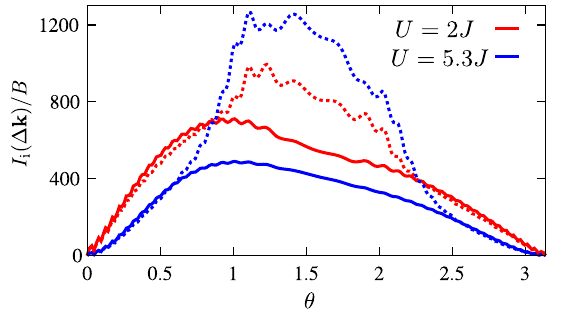
light.FIG. 12. Comparison of the angular distribution of the inelastic scattered light intensity based on MFT (solid lines) and RPA (dashed lines) at T ¼ 0 along the direction ϕ ¼ π = 4 , with κ ¼ 1 . 5 . The rest of the parameters are as in Fig. 11. The MFT and the RPA results notably differ, owing to the collective modes that significantly modify the transverse spin component. The magni- ≃ 0 . 15 ) tude of the order parameter [Eq. (15)] is m ¼ 0 . 19 ( m RPA ≃ 0 . 28 ) for U ¼ 5 . 3 J for U ¼ 2 J and m ¼ 0 . 4 ( m RPA FIG. 14. Angular distribution of the inelastically scattered light intensity at different temperatures along the direction ϕ ¼ π = 4 . The calculations are based on MFT. Here, the on-site interaction is fixed at U ¼ 5 . 3 J . This means that lower T corresponds to higher values of m . We use the same parameters as in Fig. 11. The intensity contributions from (a) the density and longitudinal spin components, (b) the transverse spin component, and (c) total scattered light intensity. An increase in temperature enhances scattering in the near-forward direction. (a)